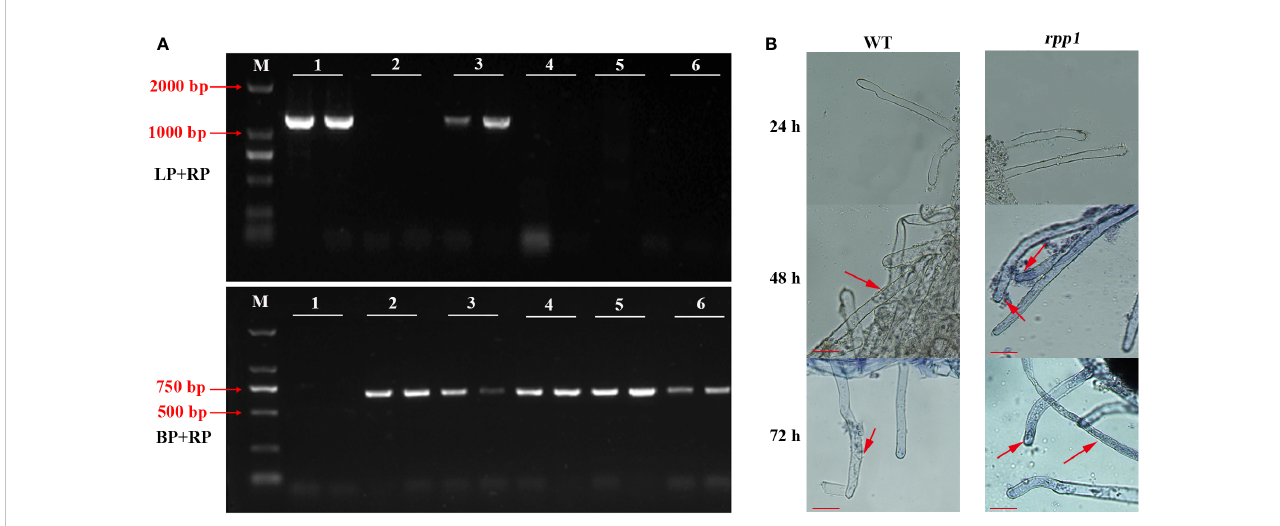
FIGURE 4 Disease resistance identi fi cation to P. brassicae in Arabidopsis mutant rpp1 . (A) The identi fi cation results of Arabidopsis mutant rpp1 by ‘ three-primers ’ . M, D2000 bp marker; 1, wild type of Arabidopsis with two replicates; 2-6, different plants of Arabidopsis mutant rpp1 with two replicates. (B) P. brassicae infection observation for wild-type (WT) and Arabidopsis mutant rpp1 . The red arrow, the position of the spore or sporangium. Scale bar=50 m m.